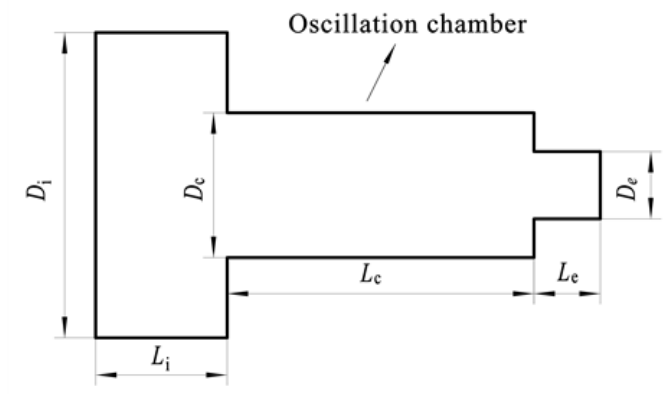
Figure 2. Photos of the main components of the experimental apparatus.